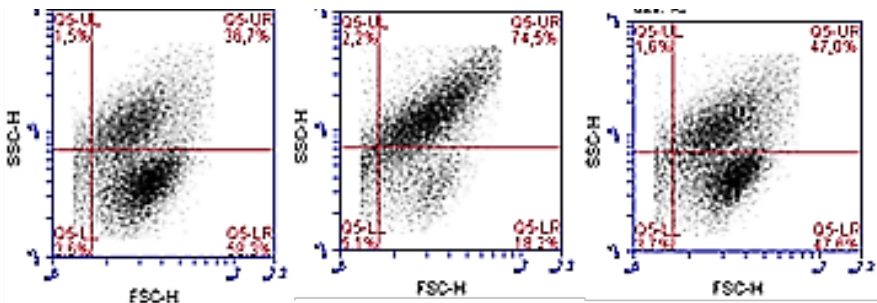
Figure 6. Jurkat T cell population distribution (%) co-cultured with HT-29 in the presence of dimethyl sulfoxide (DMSO), Compound 16 and BMS-8 from left to right. Data are representative of five experiments.